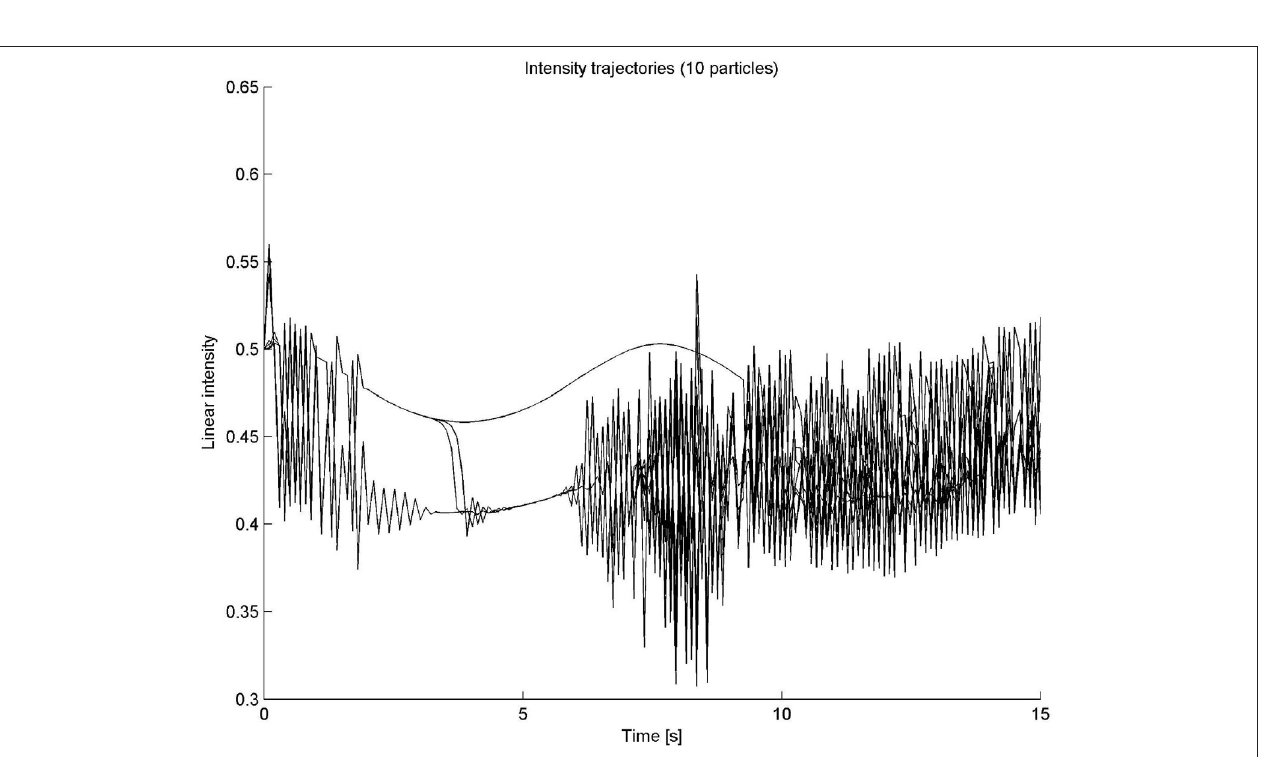
Frontiers in Artificial Intelligence |